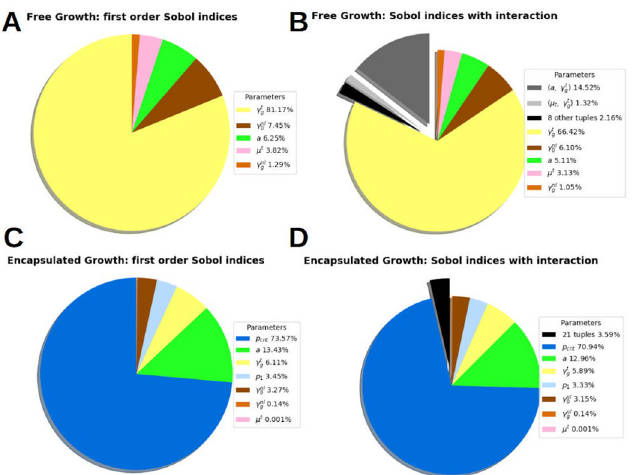
Fig 5. Validation of the calibrated parameters. Alginate Young’s modulus was estimated in [7] as E alg = 68 ± 21kPa. Simulations with the extreme values of E alg give the range of possibilities of the optimized set predicted with the model, denoted Model range due alginate stiffness in the plots. Experimental results, green dotted; Numerical results with the optimized parameter set, black; Modeling range ( E alg = 68 ± 21kPa), grey filled. A . Left, free MCTS control group, Time (Day) versus MCTS volume (mm 3 ), the model fits the experimental data with a RMSE = 0.031. Right, CCT0. The fit uses the mean experimental value of the alginate stiffness E alg = 68 kPa. The model fits the experimental data with a RMSE = 0.124. B Validation of the identified parameters on 2 thick capsules, CCT1 and CCT2. Time (Day) versus Capsule radius ( μ m). The experimental points are in the modeling range. Both capsule fit with E alg = 52.5 kPa and E alg = 70 kPa respectively. C Validation of the identified parameters on 2 thin capsules, CCT3 and CCT4. Time (Day) versus Capsule radius ( μ m). Left, one capsule is fitted with E alg = 54kPa; right, the proposed fit is given with E alg = 47kPa. However, an important part the experimental points are outside of the modeling